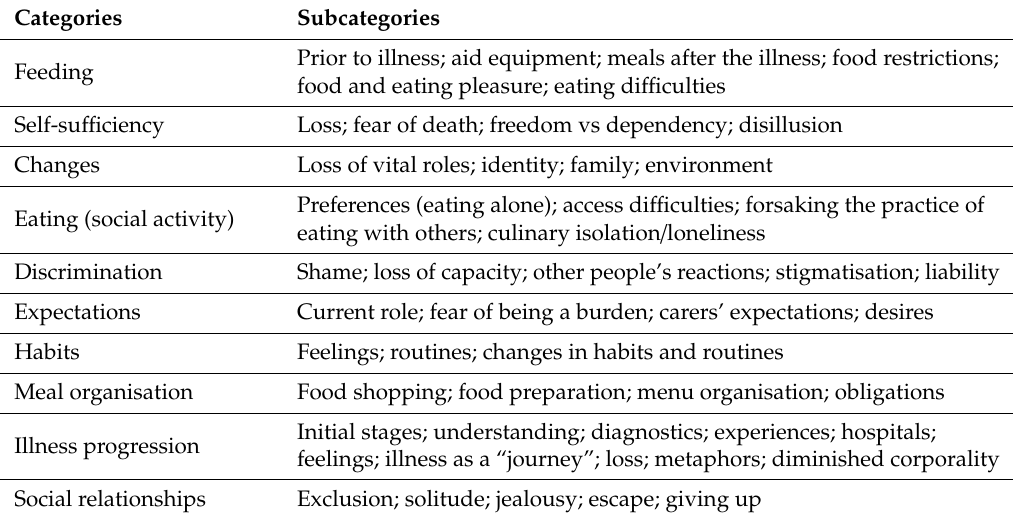
Table 3. Categories and subcategories of